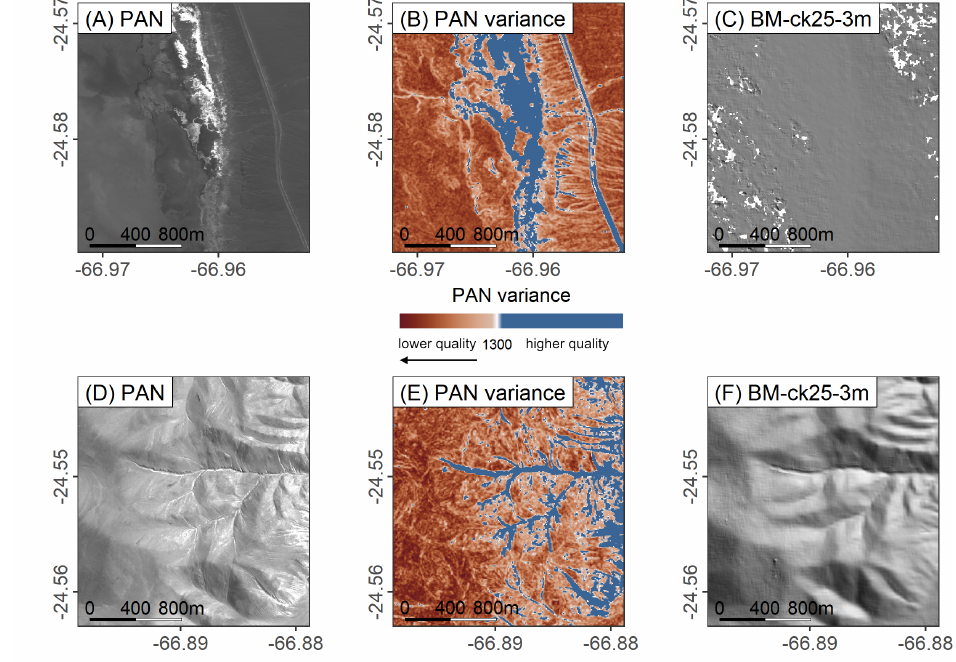
Figure 11. Relative DEM quality maps based on the PAN variance breakpoint found in Figure 10B: ( A ) map-projected SPOT6 PAN B-scene from an area bordering the salar. ( B ) 5 × 5 pixel window PAN variance for the same region, with the color bar centered on the breakpoint value (1300 PAN variance). Red colors indicate lower DEM quality (increasingly worse, as shown by the arrow), and the solid blue color indicates higher DEM quality (plateau in DEM variance vs. PAN variance relationship in Figure 10A;. ( C ) hillshade from the same salar area for the BM-ck25 DEM; ( D – F ) the same results shown for a more mountainous part of the study area. See Figure 2A for location in study